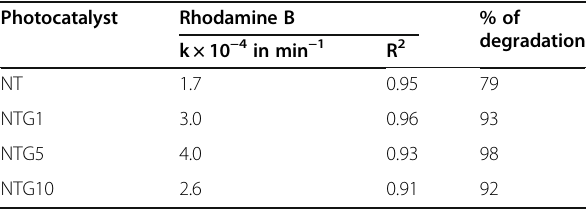
Table 2 Pseudo first-order kinetic rate constant (k), regression coefficient (R 2 ) and % of degradation of different photocatalysts for RhB dye under visible light irradiation Photocatalyst